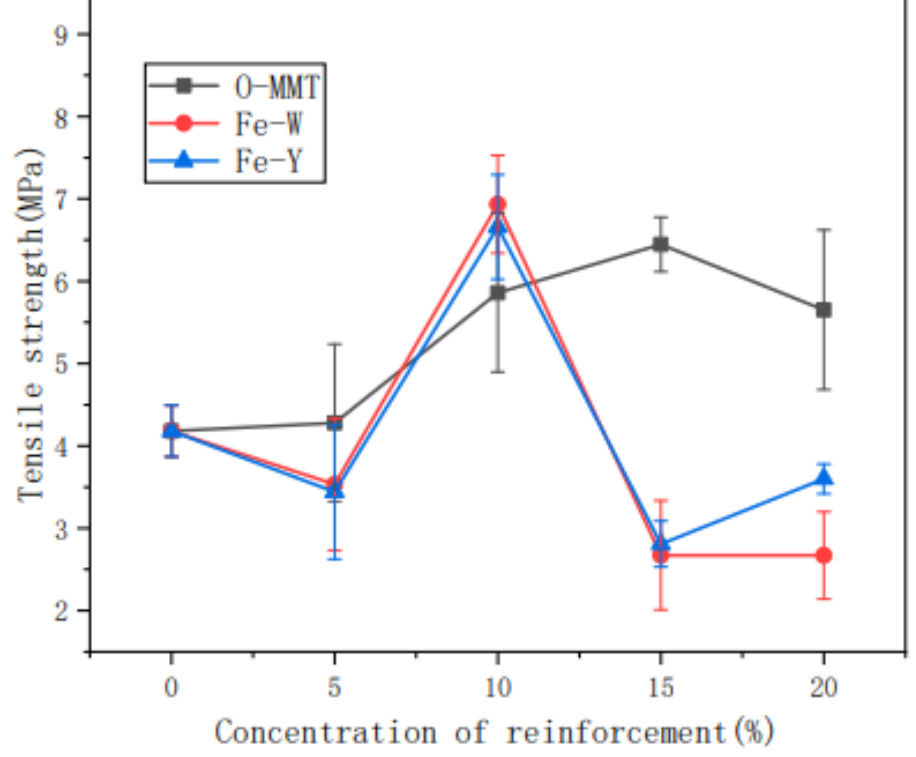
Figure 7. Tensile strength of starch films with different amounts of the reinforcement agent